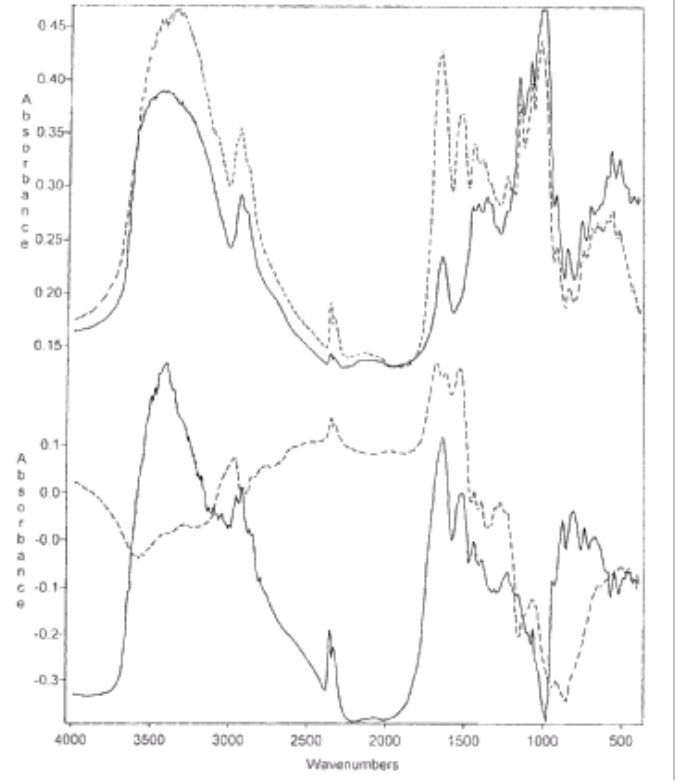
Figure 2. (1) Differential FTIR spectra of casein/GPCS 1:1 complex from which (a) the spectrum of GPCS was subtracted and (b) the spectrum of casein was added for comparison; (2) Differential FTIR spectrum of the same complex from which spectrum of casein was subtracted (a) and spectrum of GPCS (b) added for